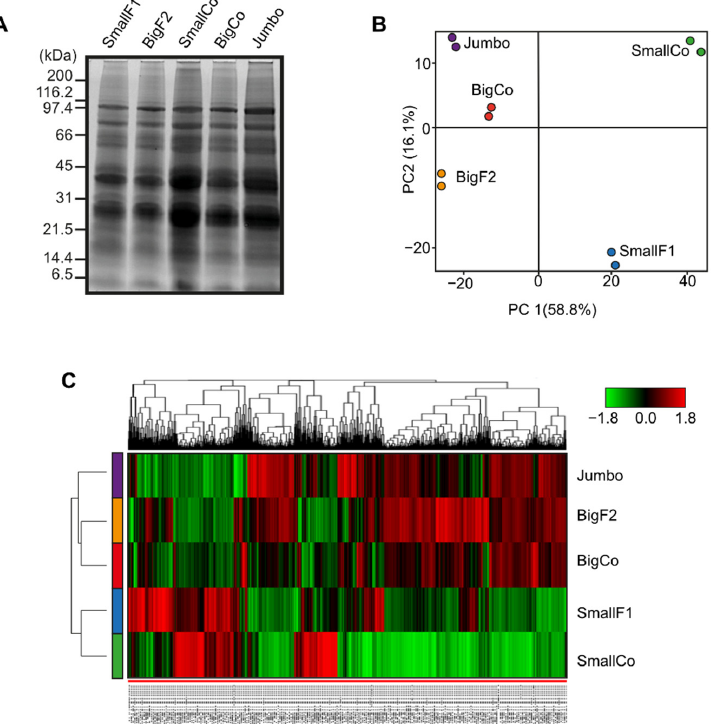
Figure 1. Comparative proteomic analysis of chickpea grain genotypes that differ in size. ( A ) Grain protein pattern visualized in an SDS-PAGE; protein standard ladder is shown on the left side of the gel. ( B ) Principal component analysis and ( C ) heatmap based on protein abundance. SmallF1 = small farmer 1; BigF2 = big farmer 2; SmallCo = small commercial; BigCo = large commercial. To analyze differential proteins, we considered a fold change value of 1.5 (log2 fold change value: 0.58) in comparison with genotypes, including BigCo and BigF2, BigCo and SmallCo, BigCo and SmallF1, and BigCo and Jumbo. Volcano plots exhibited that log2 ratios identified few differential proteins among large grain genotypes (Figure 2A,D).